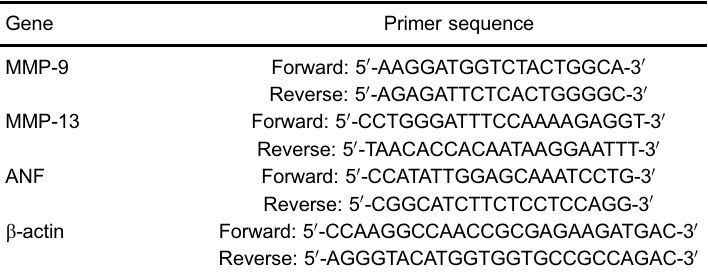
Table 1. Primer sequences for speci fi c